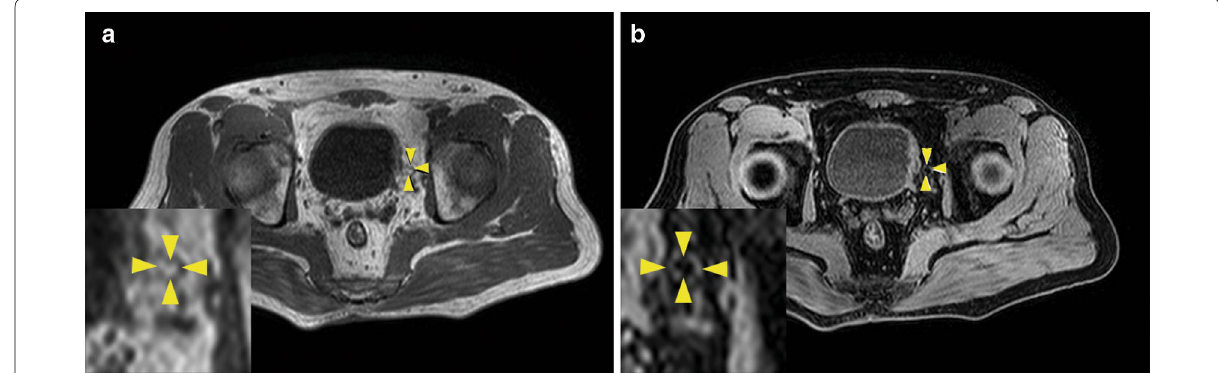
Fig. 2 Pelvic magnetic resonance (MR) images of a 62-year-old man with bladder cancer (stage pT2b). a Transverse T1-weighted MR image shows a hyperintense lymph node with round shape and a short-axis diameter of about 6.0 mm in the left perivesical region. The fatty hilum shows high signal intensity on the image (yellow arrows). b In out-of-phase MR imaging, the fat signal was suppressed in the lymph node (yellow arrows). This lymph node with fatty hilum was proved to be benign in pathologic